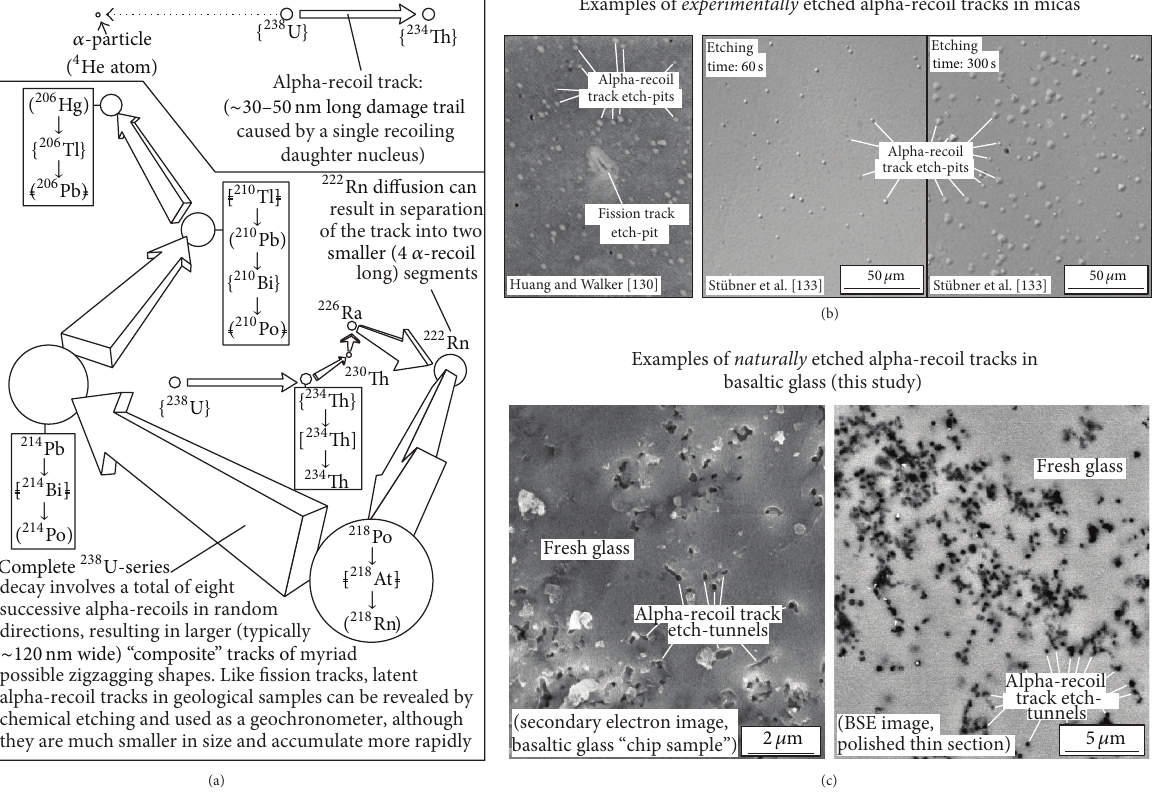
Figure 4: Background on alpha-recoil tracks and examples of alpha-recoil track etching. (a) Schematic illustration of alpha-recoil track development during complete 238 U-series radioactive decay (note: alpha-recoil tracks also originate from 235 U- and 232 Th-series decay—not shown). Beta decays are indicated by small arrows pointing down (enclosed in boxes/circles), while alpha decay parent-daughter pairs are denoted by identical bracket styles. (b) Etched alpha-recoil tracks in micas, revealed by experimental chemical etching of fresh cleavage surfaces. The image at left is of muscovite (etched for 2 hours at 20 ∘ C using 48% HF) and was obtained using phase contrast microscopy [130] (no scale bar is available for this image). The other two images (center and right) are of phlogopite (etched using 40% HF and then coated with a thin layer of carbon and imaged via an optical microscope equipped with an incident light device combined with Nomarski-Differential Interference Contrast [133]). Note the increase in average size of alpha-recoil track etch-pits with time, which is evident when comparing the 60 s and 300 s images. (c) Naturally occurring alpha-recoil track etch-tunnels (ARTETs)—identified at the glass-palagonite interface in the glassy margins of midocean ridge pillow basalts (this study). Left image: sample DSDP-418A-75-3[120–123] (see Figure 11 for petrographic context). Right image: sample DSDP-418A-68-3[40–43]